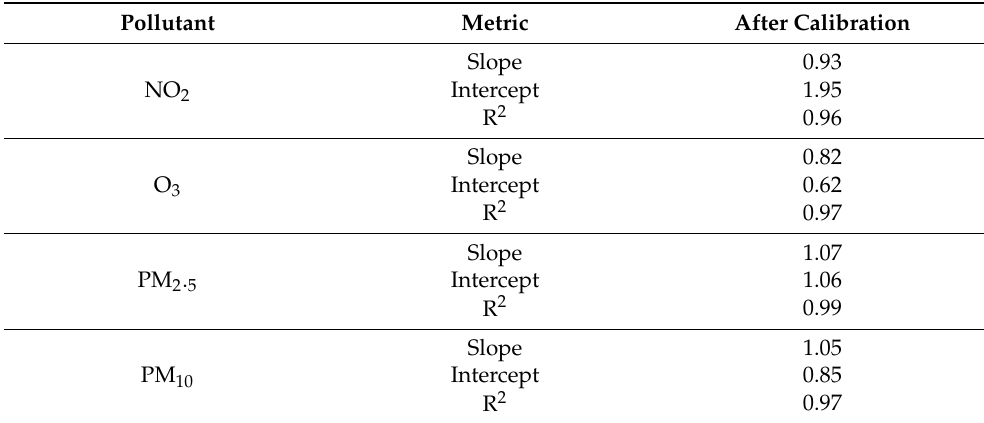
Table 2. Repeatability between BEC01 and BEC02 before and after calibration. Measurement unit is micrograms per cubic meter ( µ g/m 3